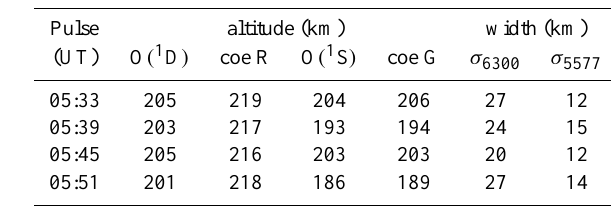
Table 1. Table 1 Altitude of excitation and emission, as estimated. Here O ( 1 D ) and O ( 1 S ) denotes excitation of respective state, for which we list the center-altitude of the generalized Gaussian, and “coe R/G” denotes center of emission for the volume emission rates at 6300 and 5577 ˚A respectively. Characteristics of volume emis- sion estimates.